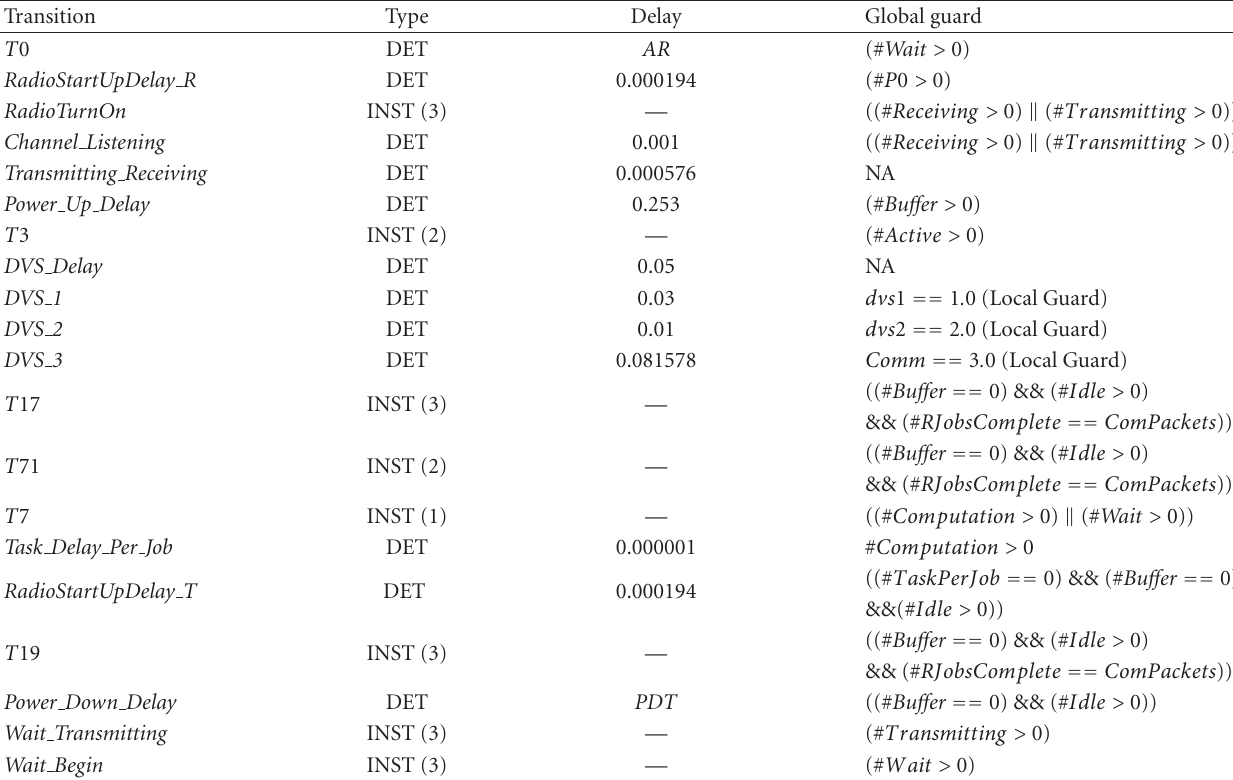
Table 11: Closed system model Petri net transition